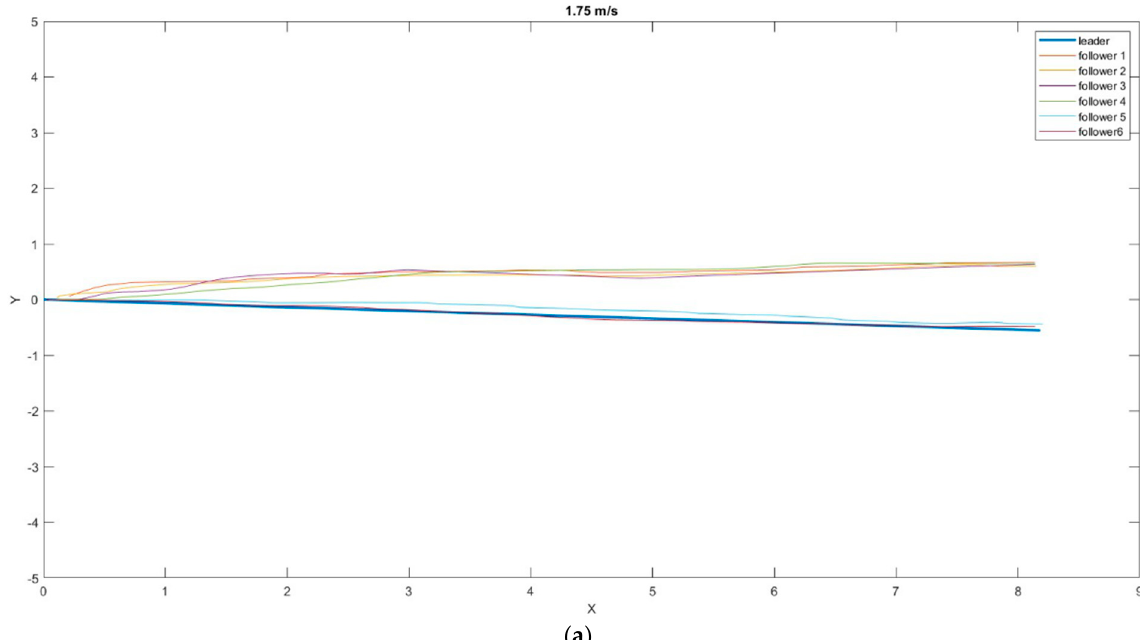
Figure 8. Flight in a straight line behind the leader. The bottom right image was taken by the camera, showing the detected marker.